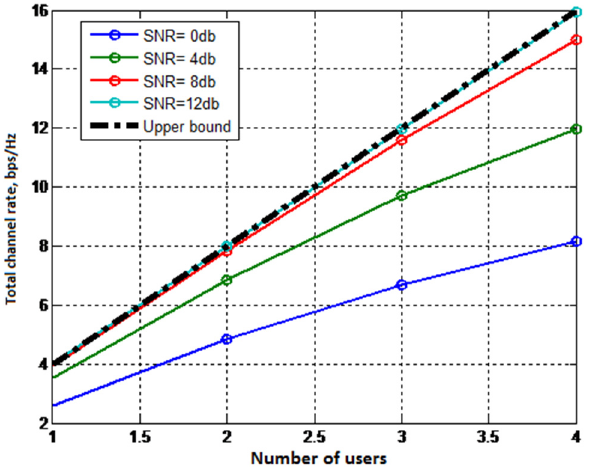
Figure 3. The dependence of MU-MIMO uplink total channel rate for discrete–continuous channel on the number of users of different values of the SNR ratio.